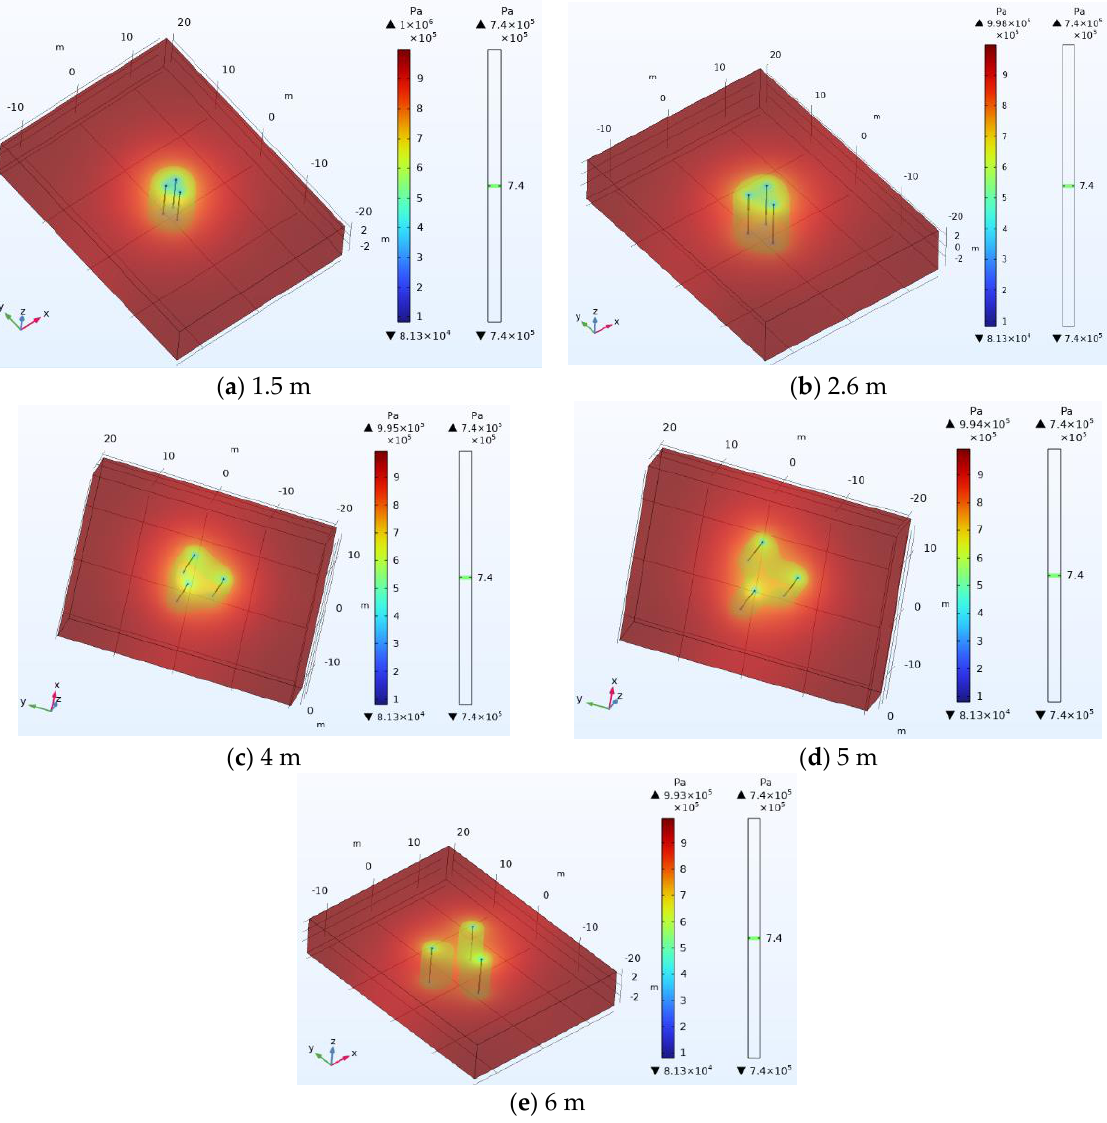
Figure 6. Effective extraction area effect diagram under different hole spacing of 140 d extraction.